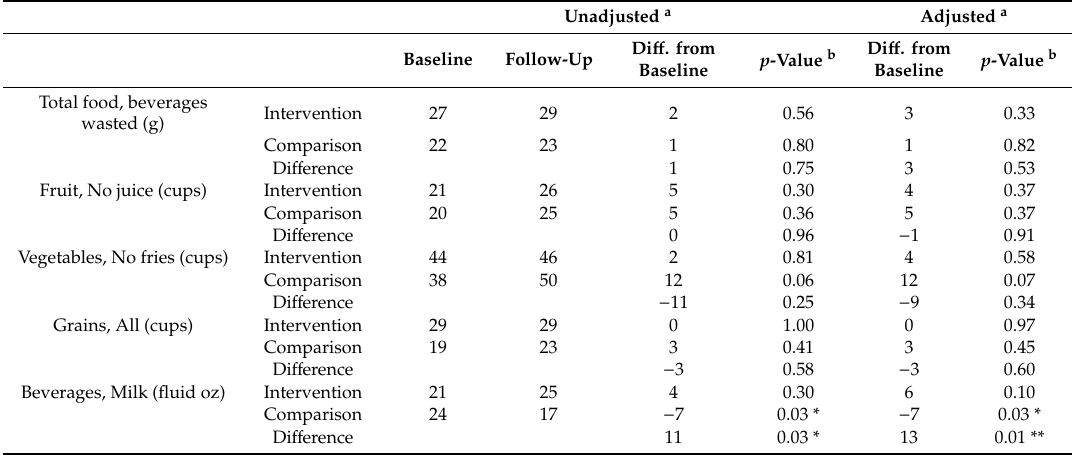
Table 3. Change in percent wasted per child per day by study arm ( n = 64 centers, averaging across included